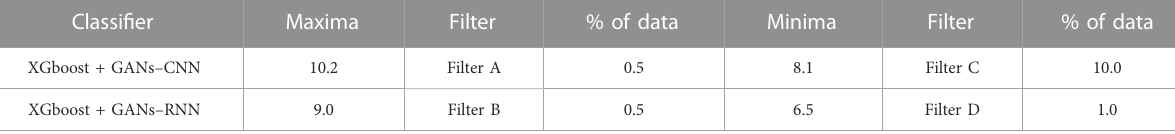
TABLE 3 Enrichment Ratios of ADORA2A on the dataset consisting of features as shown in Table 2 with training size of 30%.